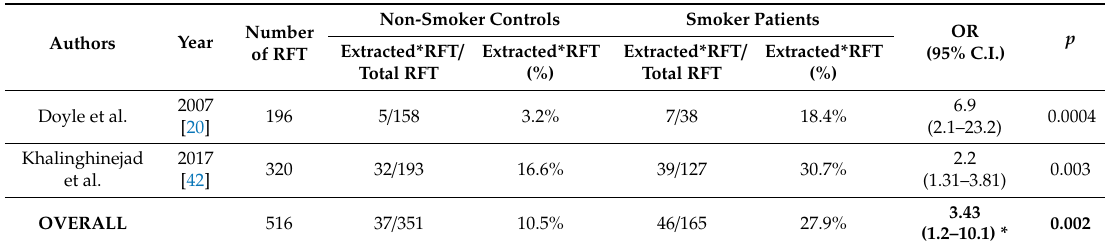
Table 3. Studies about smoking habits and the prevalence of root filled teeth extraction. Results extracted and compiled, descriptive statistics and odds ratios calculated.